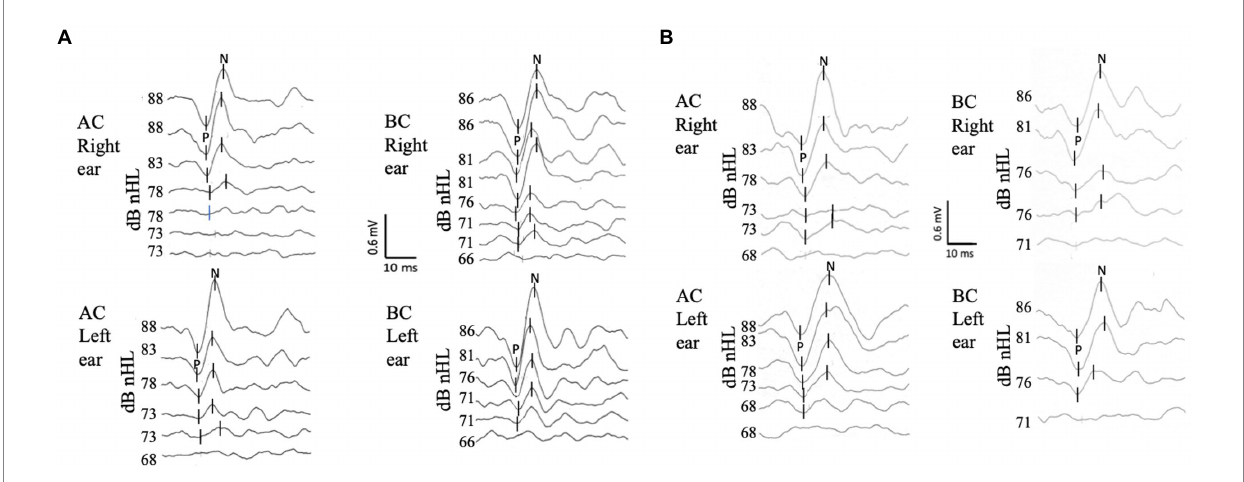
FIGURE 2 C-VEMP responses to air conduction (AC) and bone conduction (BC) stimulation for two subjects. Each trace is an average of 25 responses. P is the first peak, and N is the second peak of the biphasic c-VEMP responses. (A) 6-year-old child. The top traces for each side and mode of stimulation correspond to the reference level of our protocol 88 dB nHL (i.e., 100 dB HL) for AC and 86 dB nHL (i.e., 100 dB HL) for BC. Threshold (defined as the lowest level of stimulation where a replicable waveform was observed) were in this subject for AC 78 dB nHL on the right and 73 dB nHL on the left, and for BC 71 dB nHL on the right and 71 dB nHL on the left. (B) c-VEMP recordings for a 18 year old adult. The thresholds are in this subject: for AC 73 dB nHL s, and for BC 76 dB nHL on both sides.